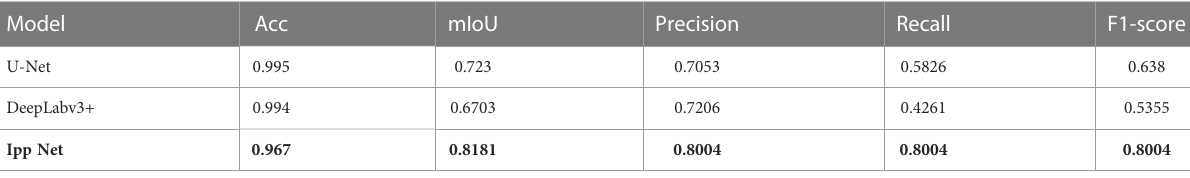
TABLE 3 Evaluation indicators.